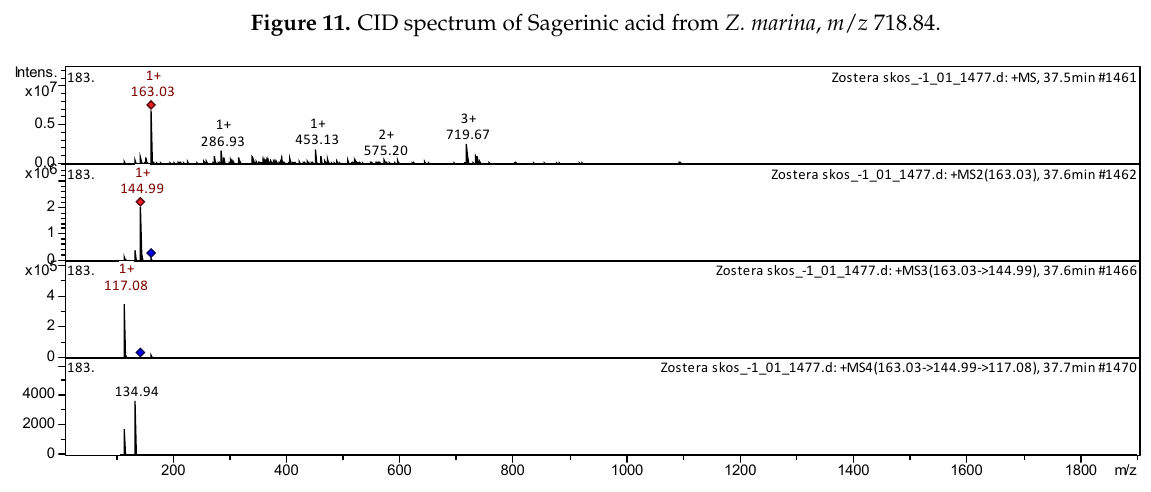
m/z 117.08 It was identified in the bibliography in extracts from F. glaucescens [9] ; San-